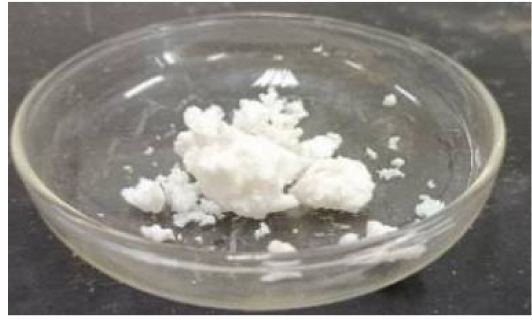
Figure 2. Synthetic product